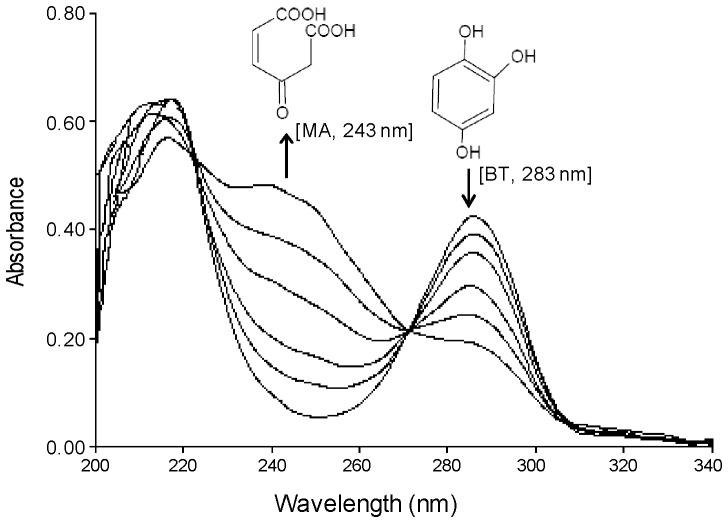
Formation of the maleylacetate (MA) from benzenetriol (BT) by crude cell extracts of Pseudomonas sp. strain FK357.Sample and reference cuvette contained phosphate buffer (50 mM, pH 7.0), 10 mM Fe (NH4)2(SO4)2.6 H2O, and 0.5 mg ml−1 protein in a 1.0-ml mixture. The reaction was initiated by addition of 70 µM BT and the spectra were recorded every 1 minute after the addition of BT. The arrows indicate the directions of spectral changes.